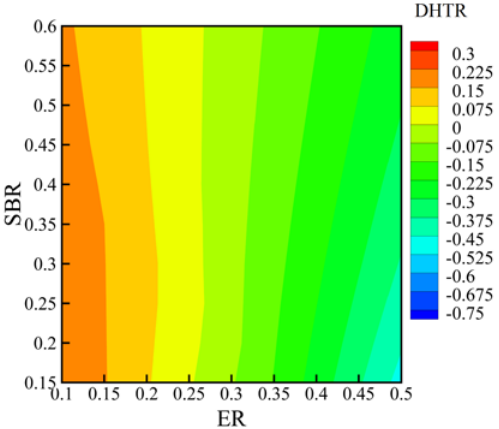
Figure 21. DHTR distribution at T = 1050 K.